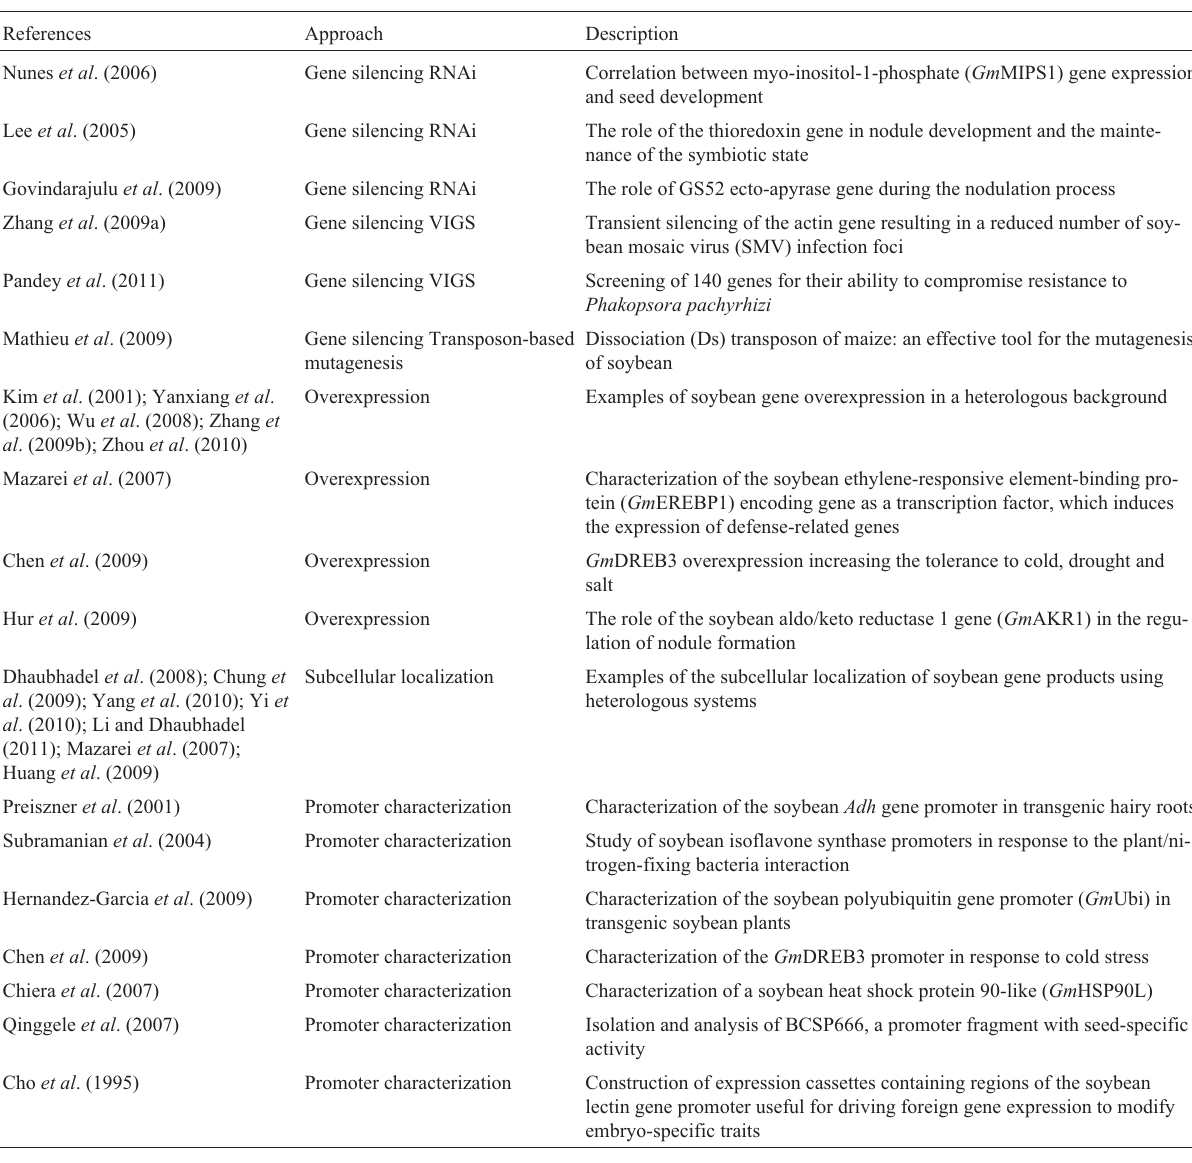
Table 1 - Functional studies of soybean genes by overexpression, silencing, transposon-based mutagenesis, protein sub-cellular localization and/or pro- moter